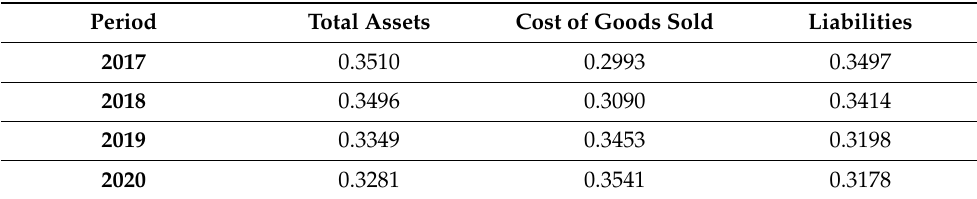
Table 14. Epsilon and weight for input/output of the EBM model